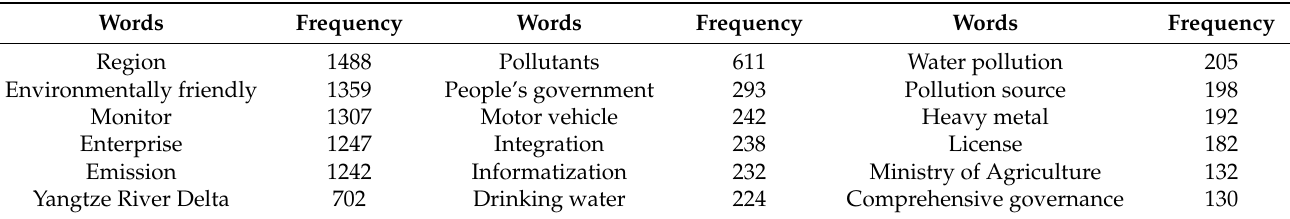
Table 2. Word cloud word frequency